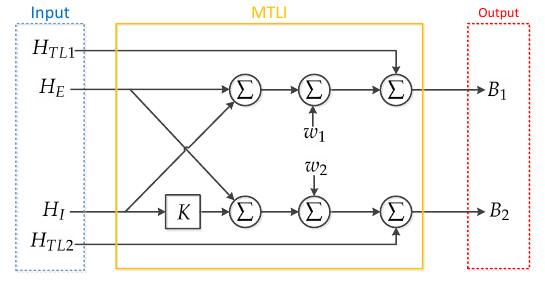
Figure 3. MTLI correlation